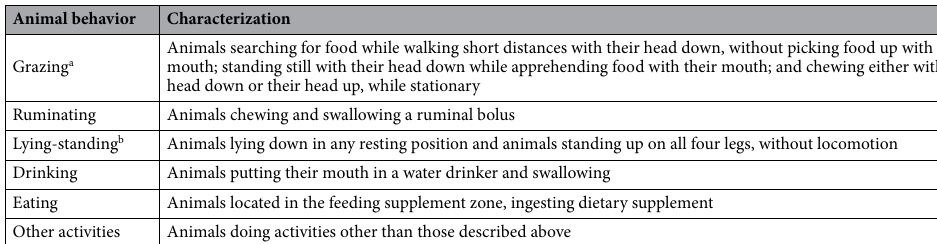
Table 3. Classification for registering different types of animal behaviour. a Supplementary Video S2. b Lying- standing: activities of lying down and standing up (Alvarenga et al. 4 , Poulopoulou et al. 7 ).